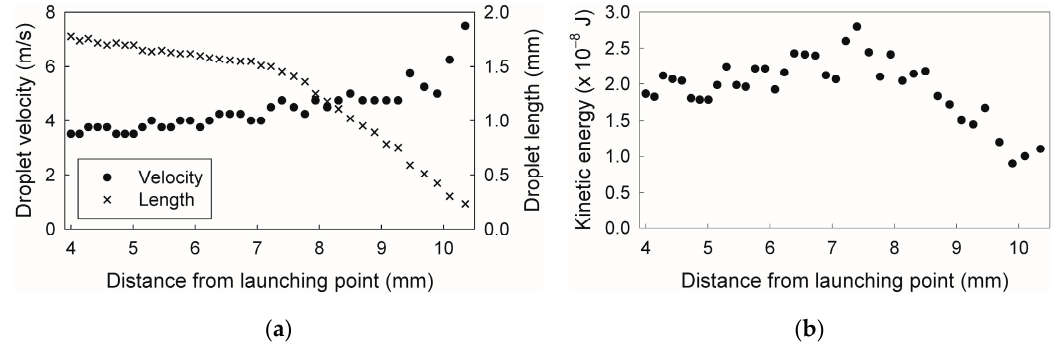
Figure 3. ( a ) Velocity, length, and ( b ) kinetic energy of accelerated droplet as functions of distance from the launching point in a microchannel with L = 2.00 mm at an applied pressure of 1800 kPa.